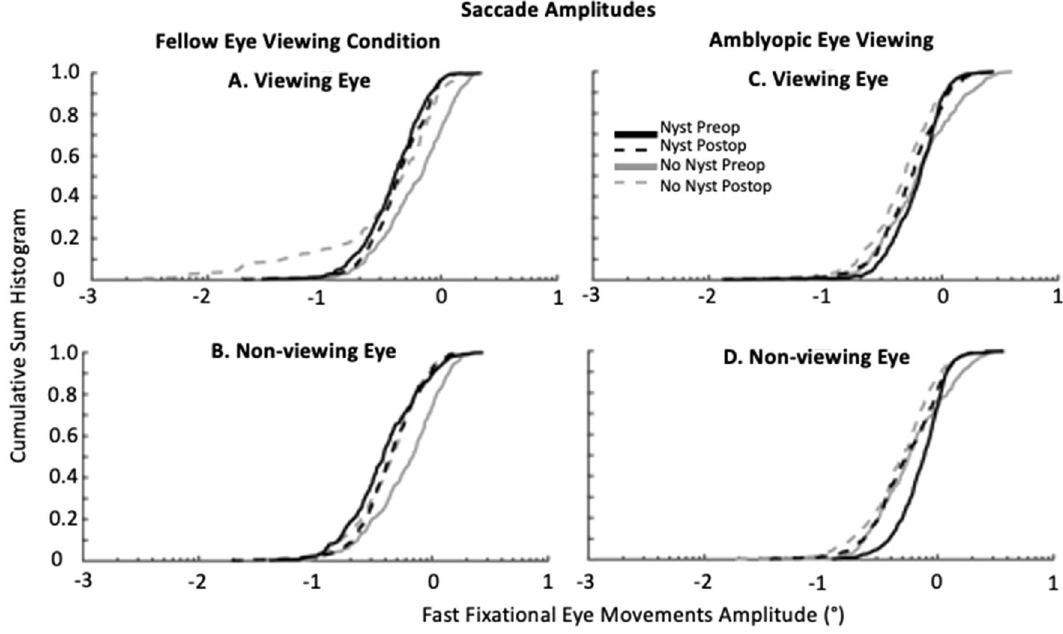
Figure 5. Cumulative sum histograms of fixational saccade amplitudes (°) of the viewing and non-viewing eye during fellow eye ( A viewing eye, B non-viewing eye) and amblyopic eye ( C viewing eye, D non-viewing eye) viewing conditions, produced during a gaze-holding task. Solid lines represent before (grey = no nystagmus, black = nystagmus), and dashed lines represent after strabismus repair (grey = no nystagmus, black = nystagmus). X-axis is log scale.